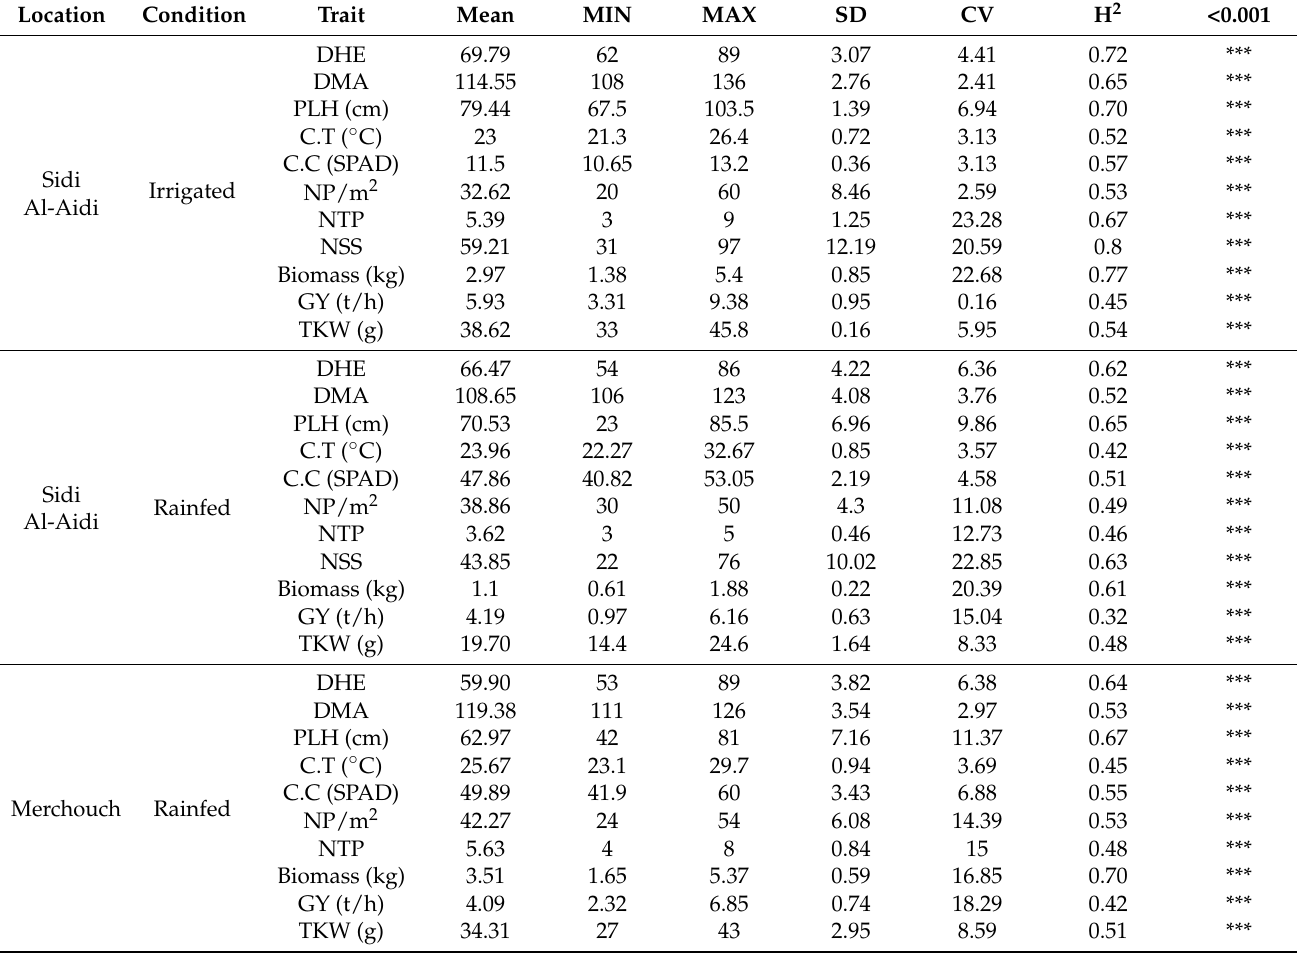
Table 1. Phenotypic variation for grain yield and yield-related traits of the 200 bread wheat genotypes under rainfed and irrigated